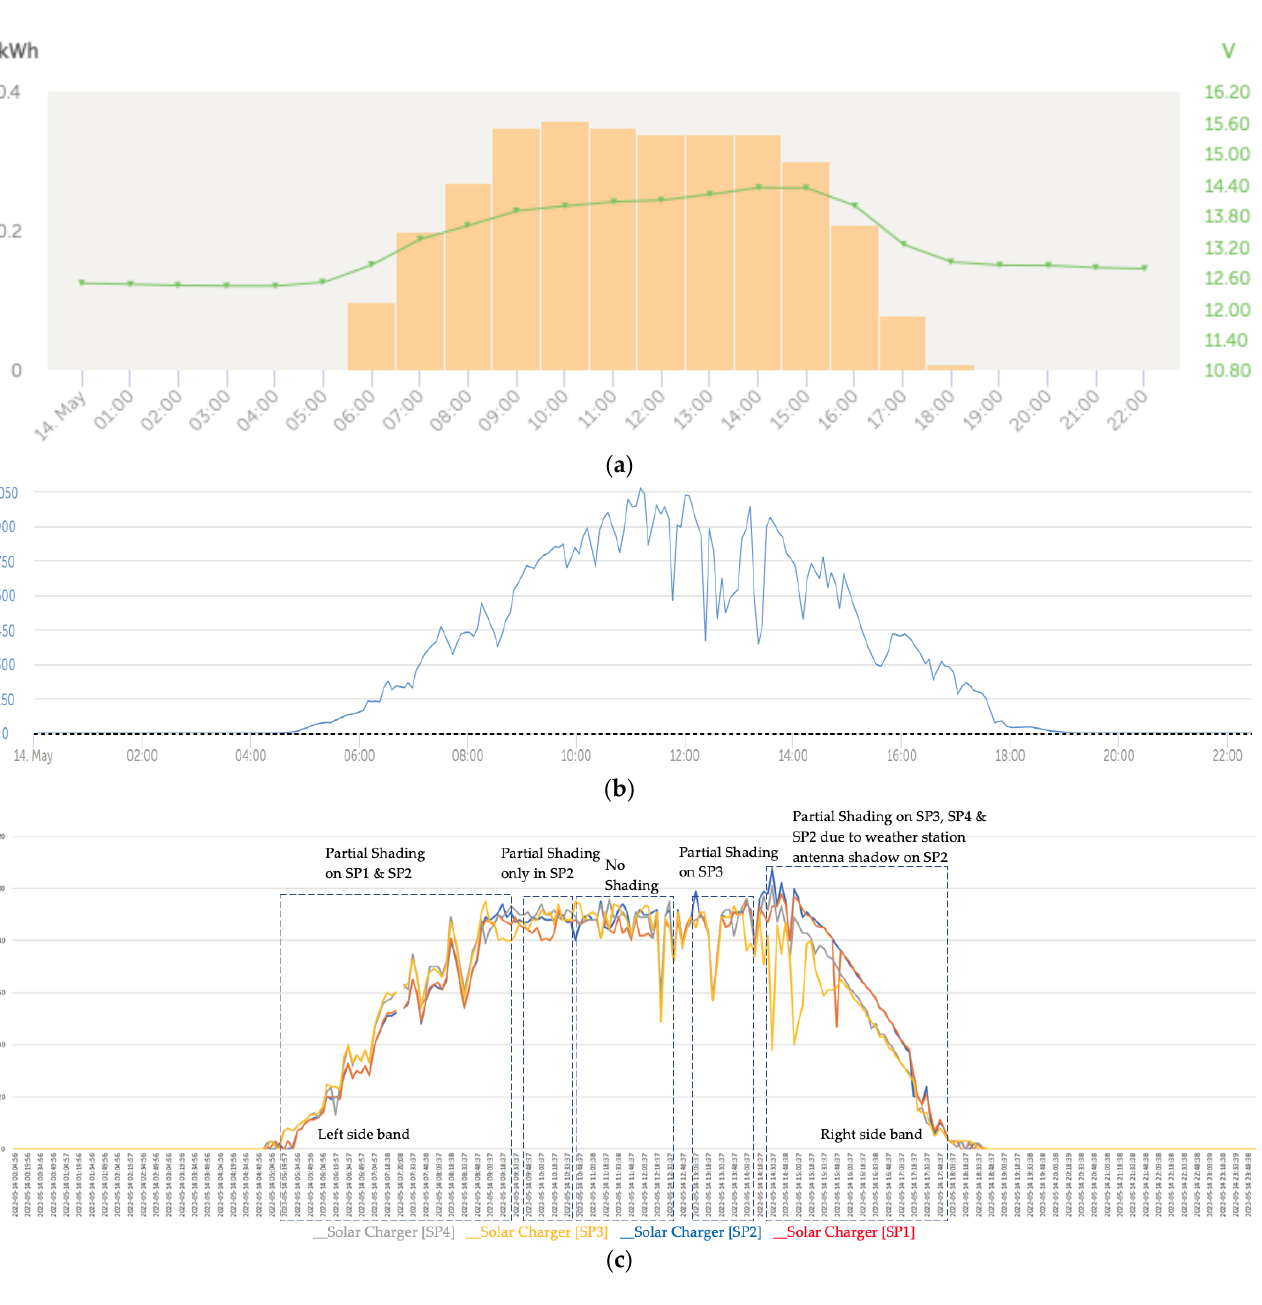
Figure 22. ( a ) Daily charge phases: initial, absorption, and flotation (14 May). ( b ) Solar Irradiance (14 May). ( c ) Deviation Trend Comparative PV Power Data Series Analysis (14 May).